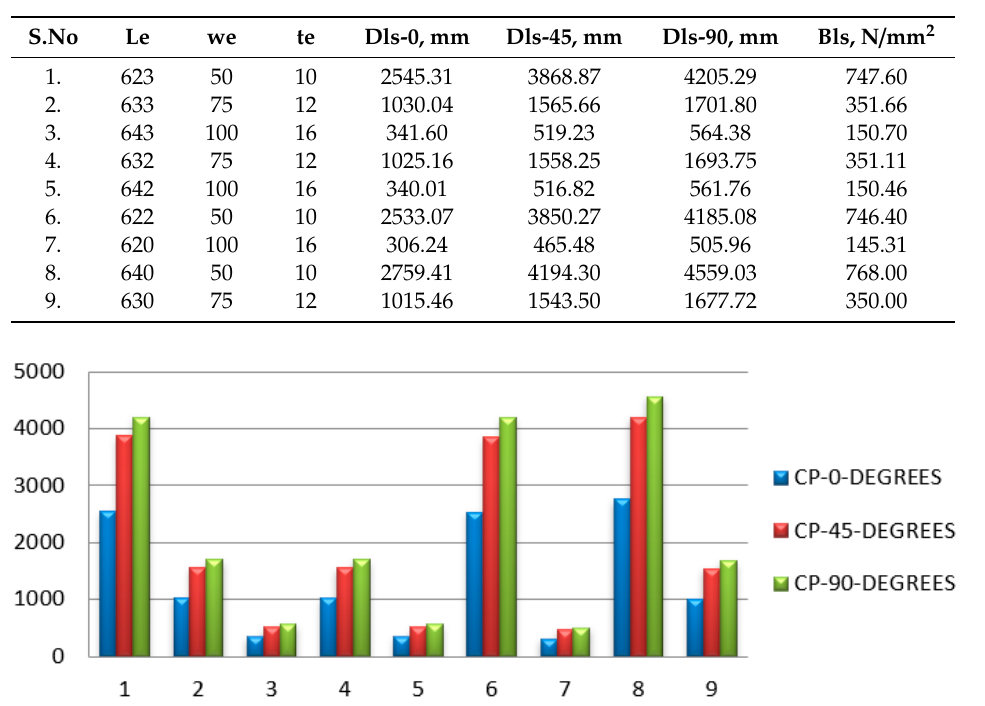
Table 6. Maximum deflection of di ff erent carbon PEEK fiber orientations.